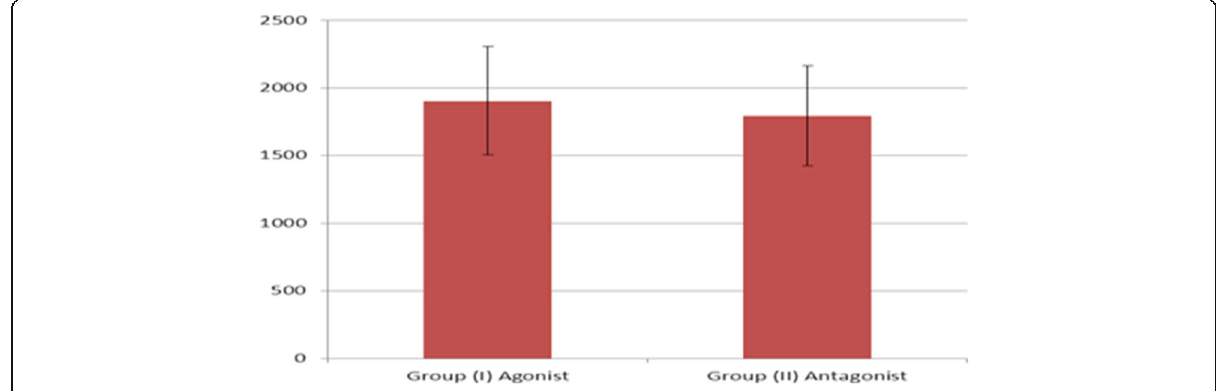
Fig. 1 Box plots representing the median and interquartile range (IQR) values for the doses of rFSH in both groups